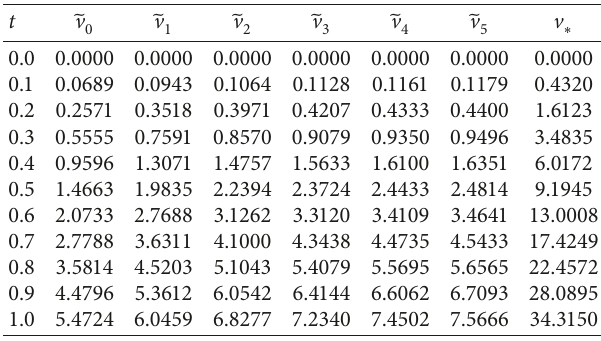
Table 2: Iterative process of 􏽥 v